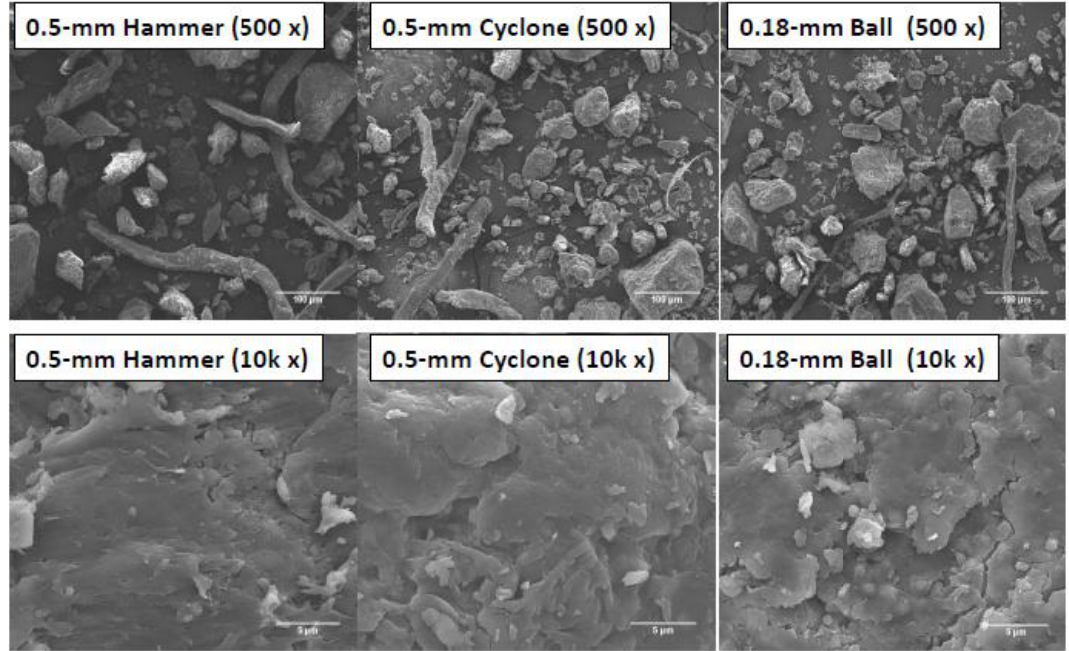
Figure 2. SEM images, with 500- and 10,000-times magnifications, of WCSM products ground by three mills and passed through 0.5-mm and 0.18-mm screens, respectively.